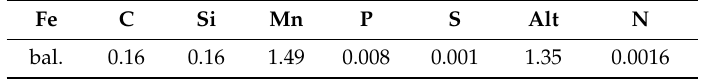
Table 1. Main chemical composition of Al-TRIP (Transformation Induced Plasticity) steel, wt.%.